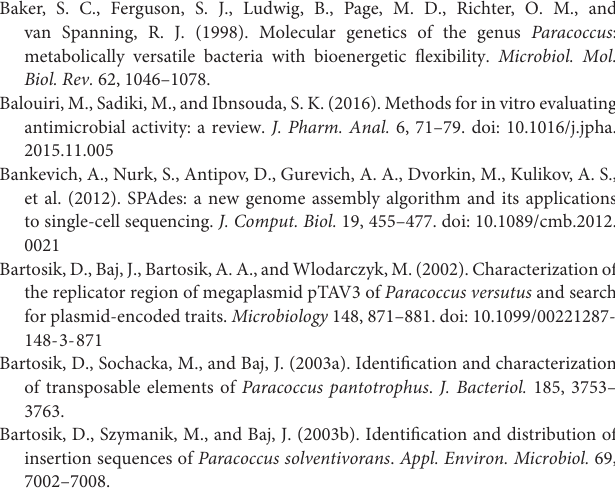
TABLE S1 | Plasmids and oligonucleotide primers used in this study. TABLE S2 | Detailed description of comparative genomic analyses performed using EasyFig and Circoletto.